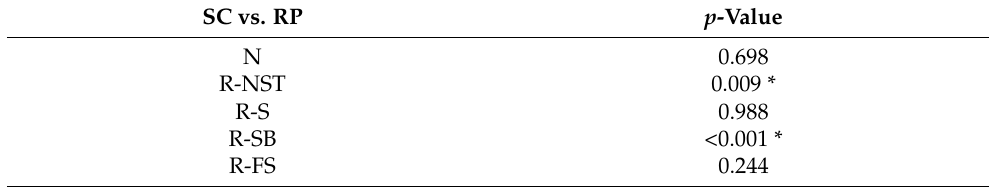
Table 3. Shear bond strength comparisons between Symetri Clear™ and Radiance Plus ®